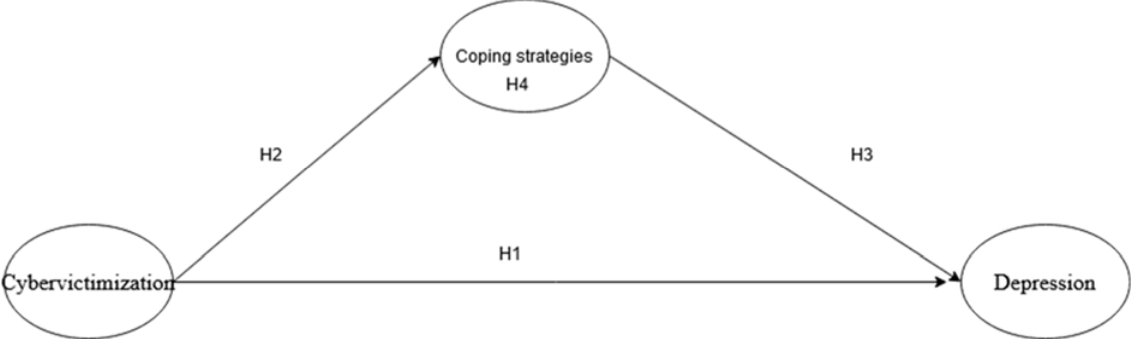
Figure 1. Conceptual Framework.